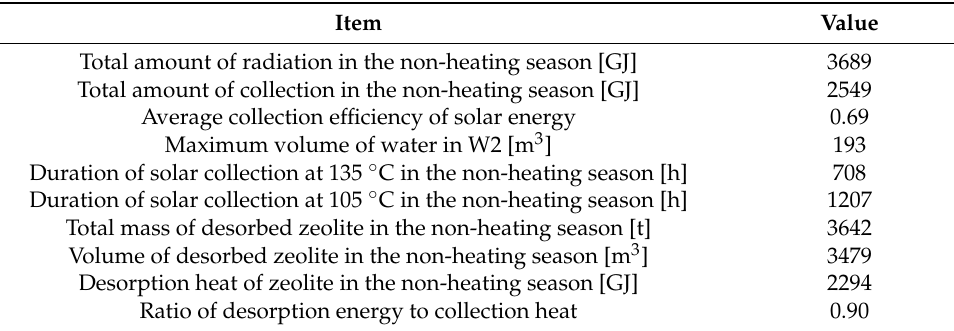
Table 3. Simulation results for the non-heating season.